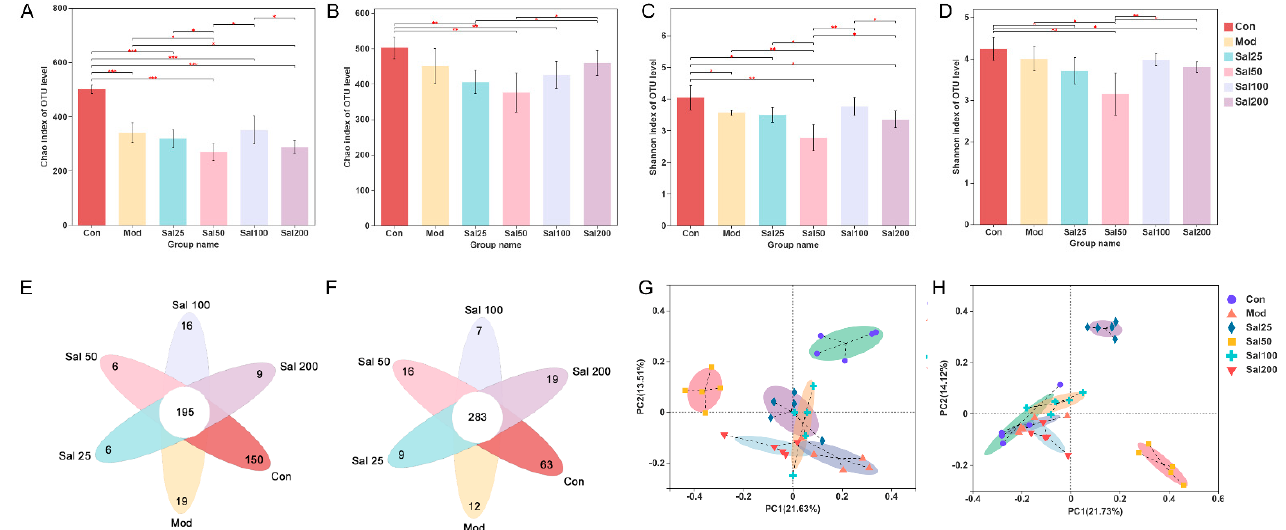
Figure 3. The effects of salidroside on the structure of gut microbiota. ( A , B ) Changes in Chao indexes after 7 and 14 days, respectively. ( C , D ) Changes in Shannon indexes after 7 and 14 days, respectively. ( E , F ) Veen analysis after 7 and 14 days, respectively. ( G , H ) Principal co-ordinates analysis (PCoA) analysis after 7 and 14 days, respectively. * p < 0.05, ** p < 0.01, *** p < 0.001. At the phylum level, Bacteroidota and Firmicutes still dominated after salidroside treatment for 7 and 14 days (Figure 4). On the 7th day, the Firmicutes / Bacteroidota ratio of the Sal25 (32.44%), Sal50 (105.05%), and Sal100 (30.56%) groups were higher than that of the Mod (29.65%) and Con (23.15%) groups, among which the Sal50 group showed the largest ratio. The abundances of Actinobacteria phylum in the groups of Sal25 (11.95%), Sal50 (6.54%), and Sal100 (6.64%) were strikingly higher than those in the Mod (5.10%) and Con (2.41%) groups on the 7th day, the trend of which maintained until the 14th day. In particular, the increase of Actinobacteria in the Sal25 group was the most significant, indicating that low-dose salidroside could rapidly raise the proportion of Actinobacteria . Additionally, salidroside showed a significant promoting effect on the growth of Verrucomicrobiota on the 7th day. The abundances of Verrucomicrobiota in the Sal25 (3.76%), Sal50 (11.00%), Sal100 (6.27%), and Sal200 (5.37%) groups were higher than those in the Mod (2.12%) and Con (1.81%)